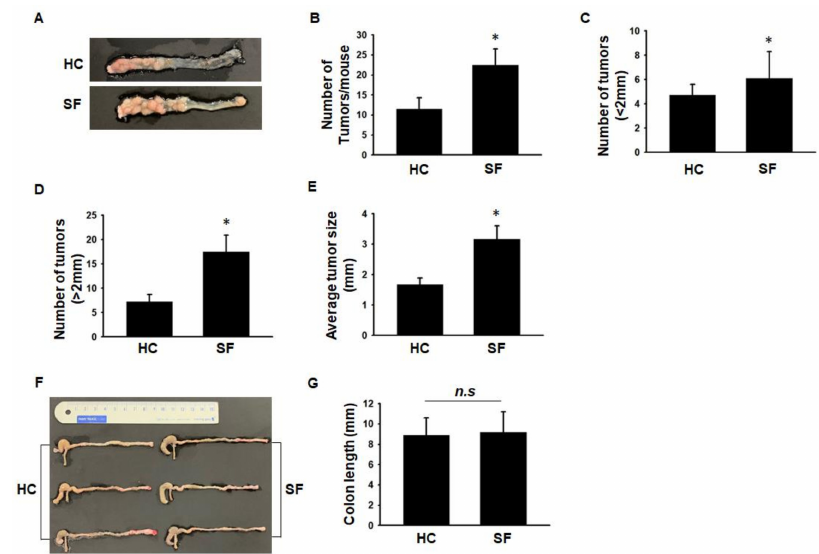
Figure 1. Tumor growth in mice in the home cage control (HC) and sleep fragmentation (SF) groups. ( A ). Macroscopic view of colon tumors that developed in the mice of the HC and SF groups. ( B ). Comparison of the number of tumors. ( C ). Comparison of the number of tumors < 2 mm. ( D ). Comparison of the number of tumors > 2 mm. ( E ). Average tumor size in the HC and SF groups. ( F ). Representative images of mouse colons from the HC and SF groups. ( G ) Comparison of colon lengths between the HC and SF groups. Data are presented as the mean ± S.E.M. * p < 0.05 compared with the HC group, as determined by the Mann-Whitney U test. n.s. non-significant.